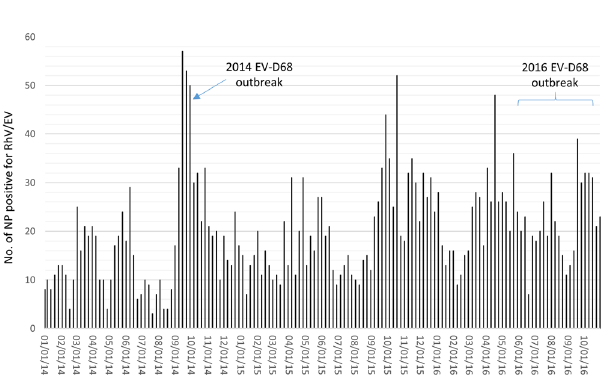
Table 1. Number of nasopharyngeal specimens examined by FilmArray RP during the period from 2014 to 2016. a One or more target(s) detected by the FilmArray RP assay.